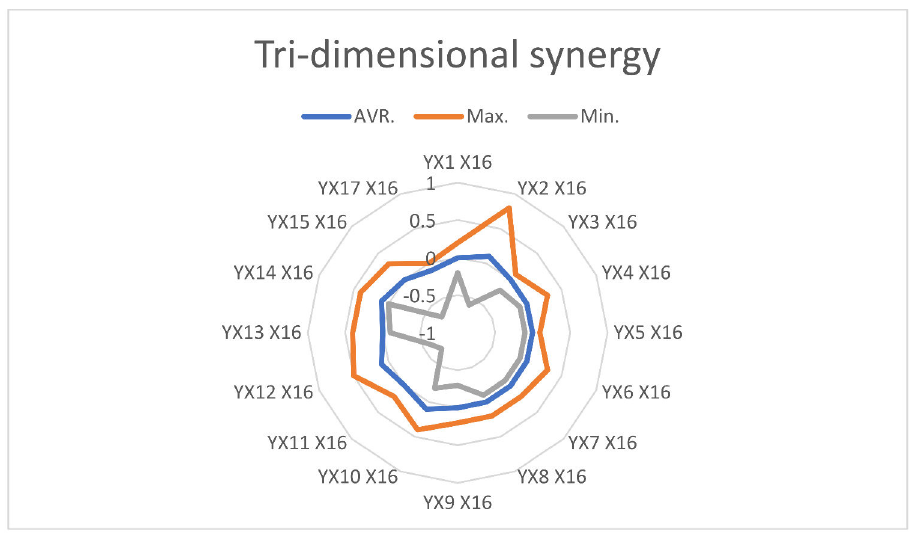
Figure 10. Tri-dimensional synergies in rapport with wealth/real GDP per capita (X 16 ). Source: Authors’